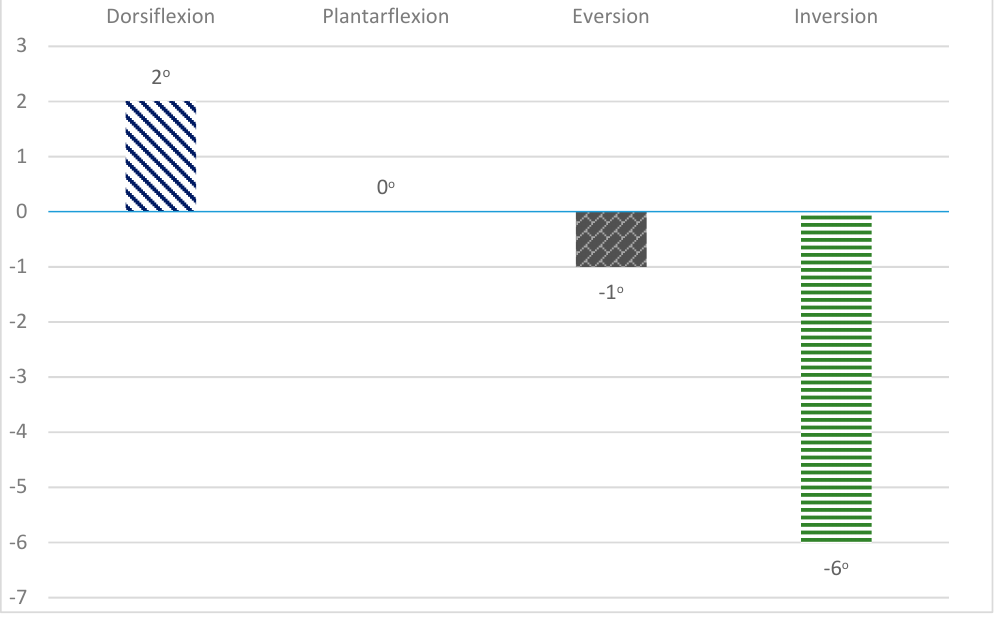
Figure 8. Differences in degrees between software application and therapist.